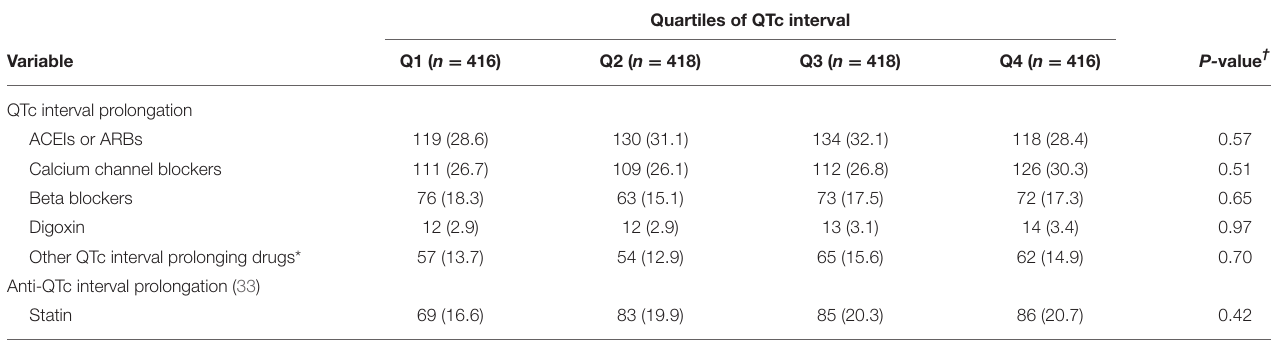
TABLE 3 | Medications affecting QTc interval according to the quartiles of the QTc interval.